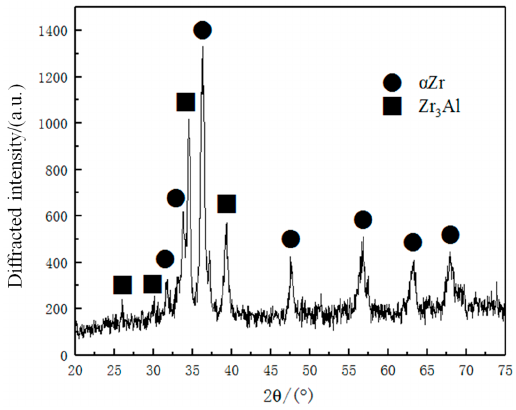
Figure 7. XRD result.